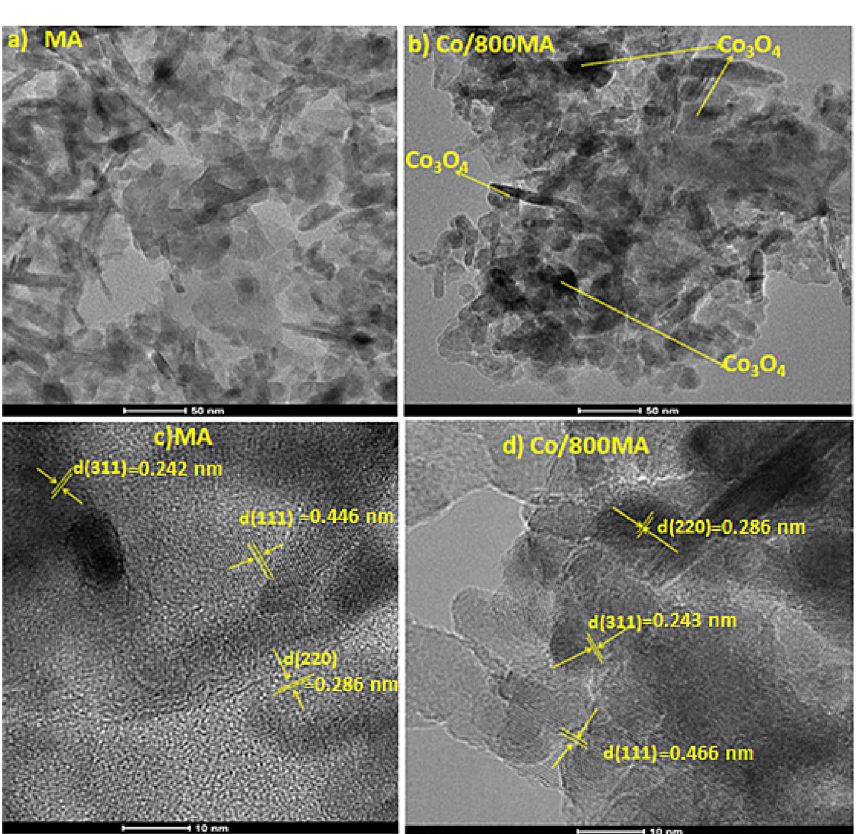
Figure 5. HRTEM images of 800MA spinel (MA) and 15Co/800MA